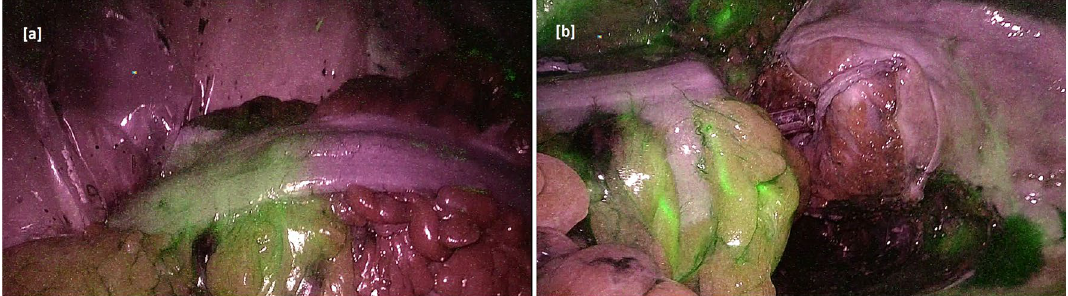
Figure 2. Intraoperative use of ICG technology. Fluorescence angiography shows the vascular perfusion of the intestinal segment that delimits the section point ( a ). Anastomosis is performed with the residual colon ( b